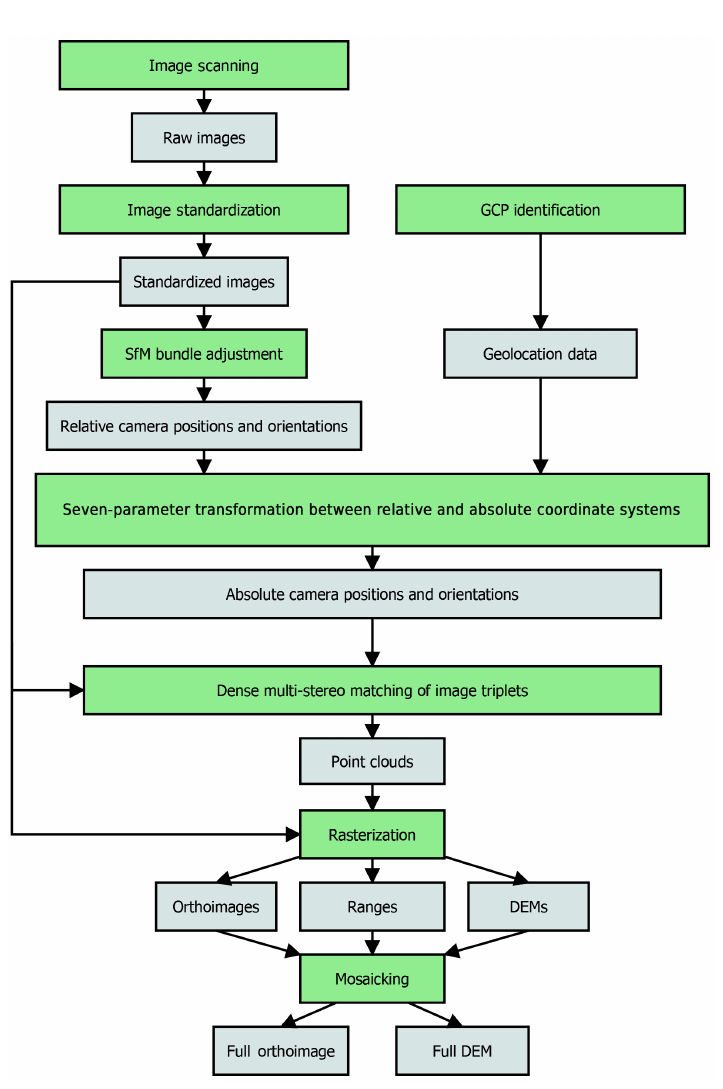
Figure 2. Workflow of the structure-from-motion photogrammetric pipeline used in this paper. Data are represented in gray and processes in green.